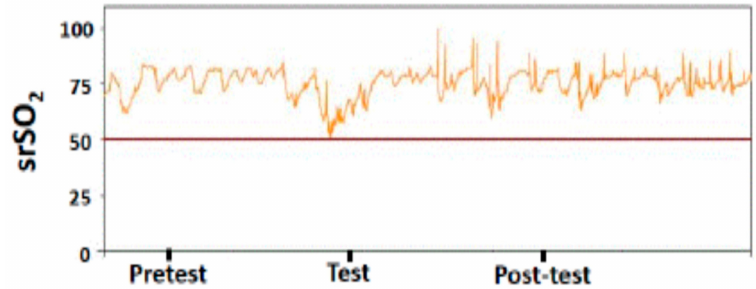
Figure 4. Splanchnic regional oxygen saturation (srSO 2 ) pattern recorded before, during and after osteopathic manipulation